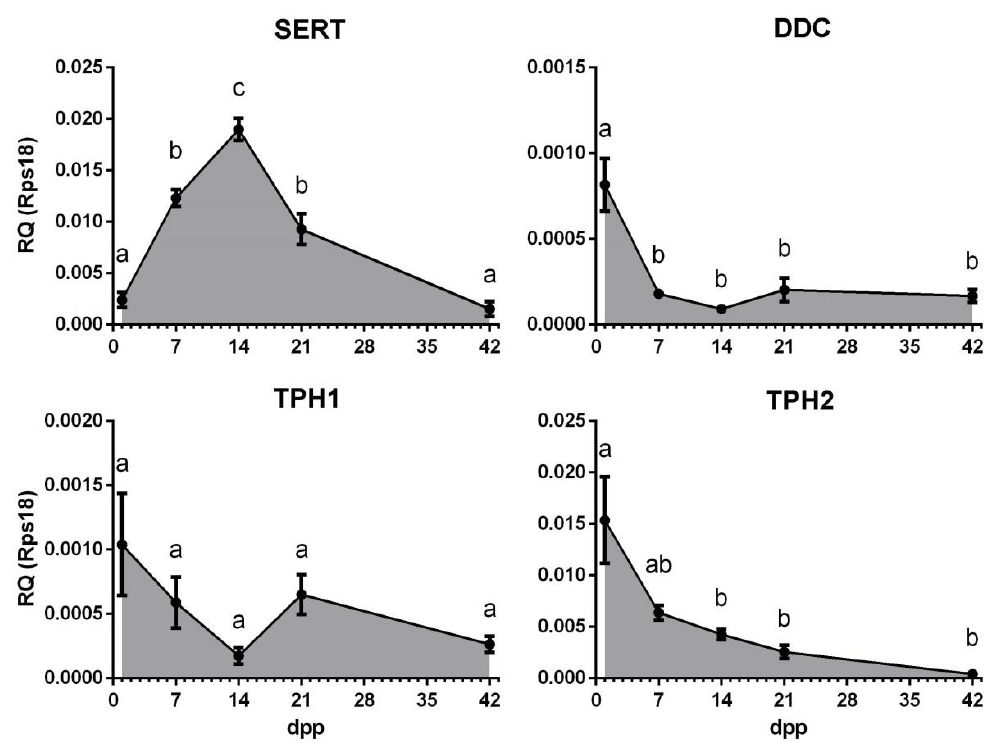
Figure 1. Gene expression profiles of the serotonin transporter SERT and enzymes of serotonin synthesis DDC , TPH1 and TPH2 , during postnatal development of the mouse ovary. The relative quantity (RQ) was calculated using 2 −ΔCt method relative to the reference gene RPS18 (M ± SEM). Different letters denote statistical significance between groups at p < 0.05, according to ordinary one-way ANOVA with Holm-Sidak’s multiple comparisons test.